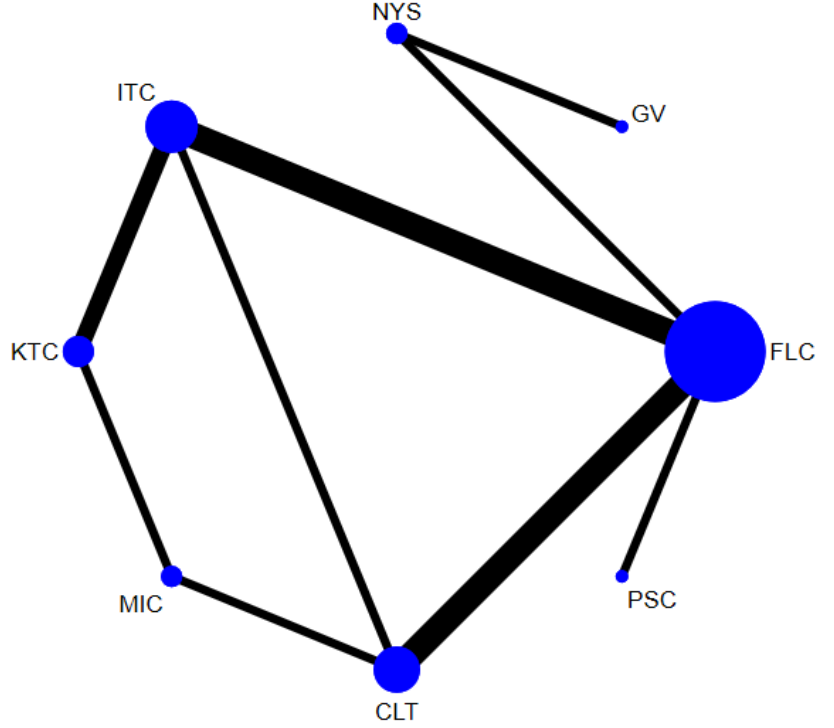
Figure 3. Network plot comparing the efficacy of antifungal agents used for the treatment of OPC among HIV-infected adults (clinical cure). Abbreviations: CLT — clotrimazole, FLC — fluconazole,